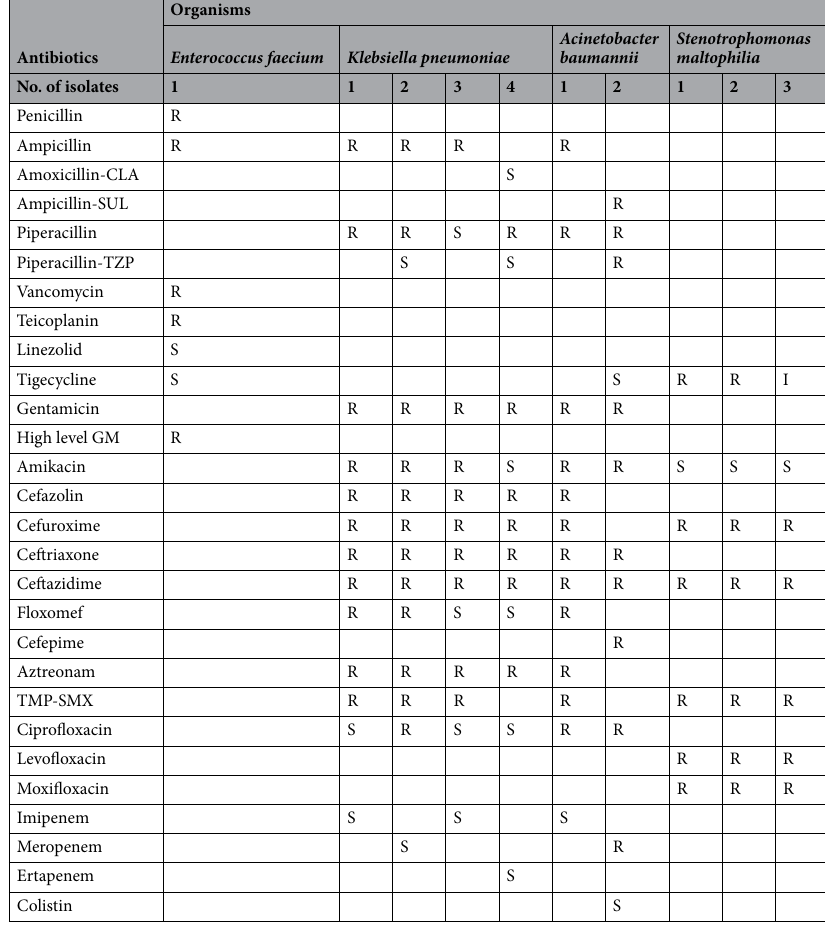
Table 4. Antibiotic susceptibility testing in multidrug-resistant organisms. CLA clavulanic acid, I intermediate, S susceptible, SUL sulbactam, R resistant, TMP-SXT trimethoprim-sulfamethoxazole, TZP tazobactam.